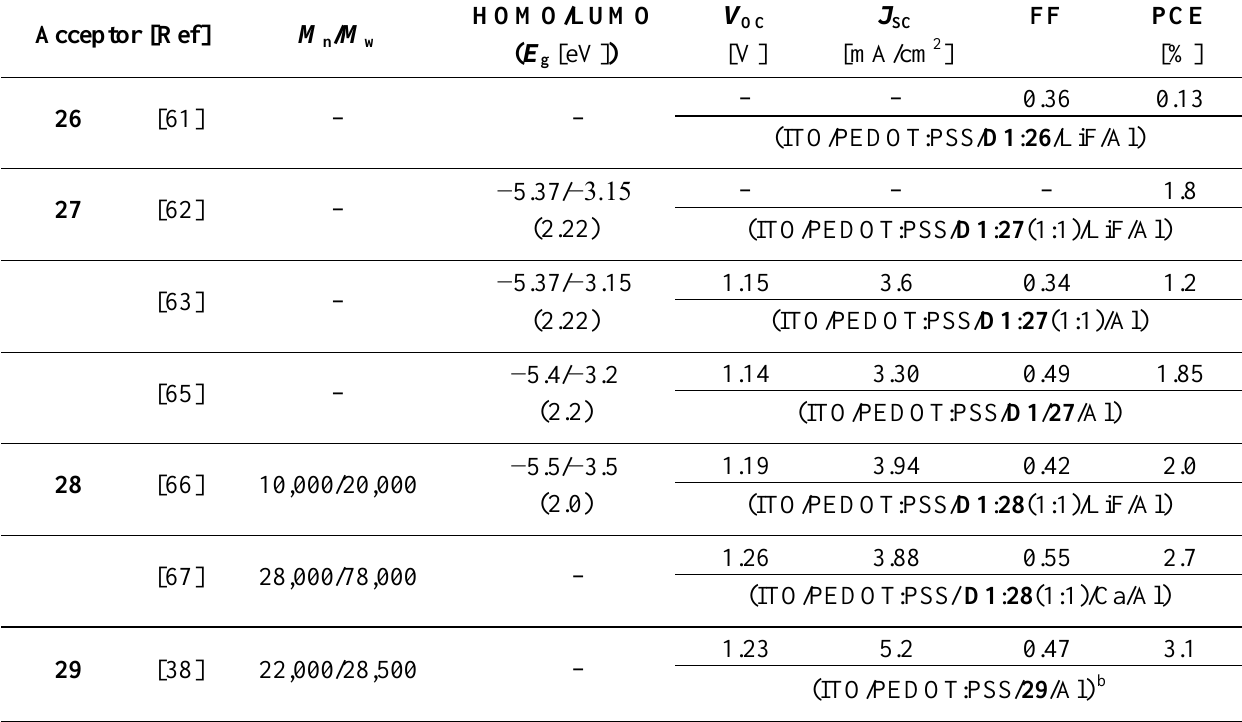
Table 3. Fluorene and benzothiadiazole (BT)-based polymer acceptors a